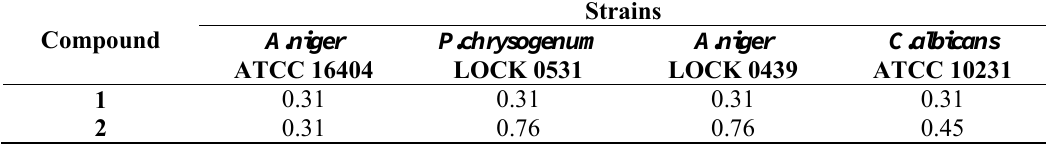
Table 4. (MIC, μ M/mL) of hexamethylene-1,6-bis( N,N -dimethyl- N- dodecylammonium bromide) ( 1 ) and pentamethylene-1,5-bis( N,N -dimethyl- N -dodecylammonium bromide) ( 2 ) for mycelium and